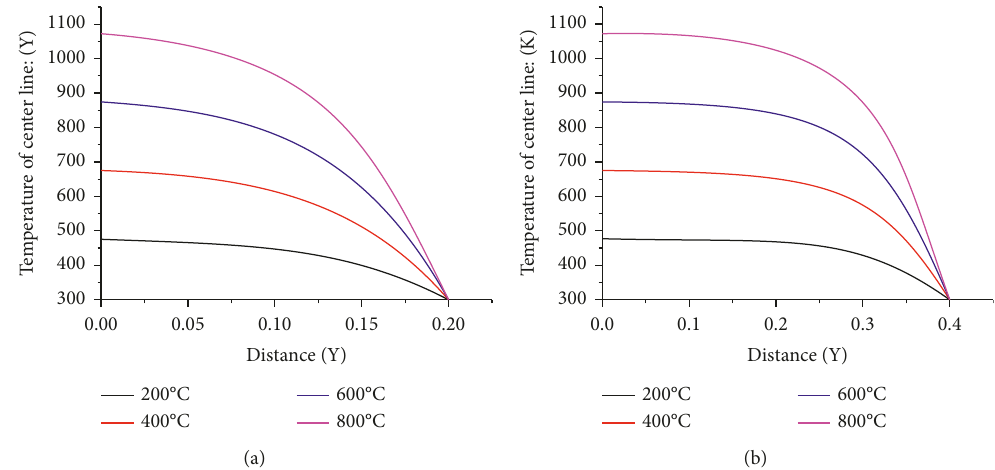
400mm. (a) Isotherm contour at 600 ° C. (b) Isotherm contour at 800 ° C. ×